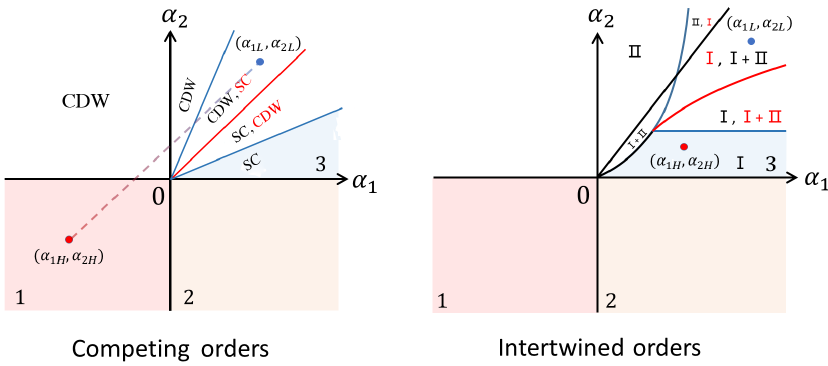
. If α lies in the colored regions, as illustrated by the red dots, iH iH t Þ in the cooling i ð